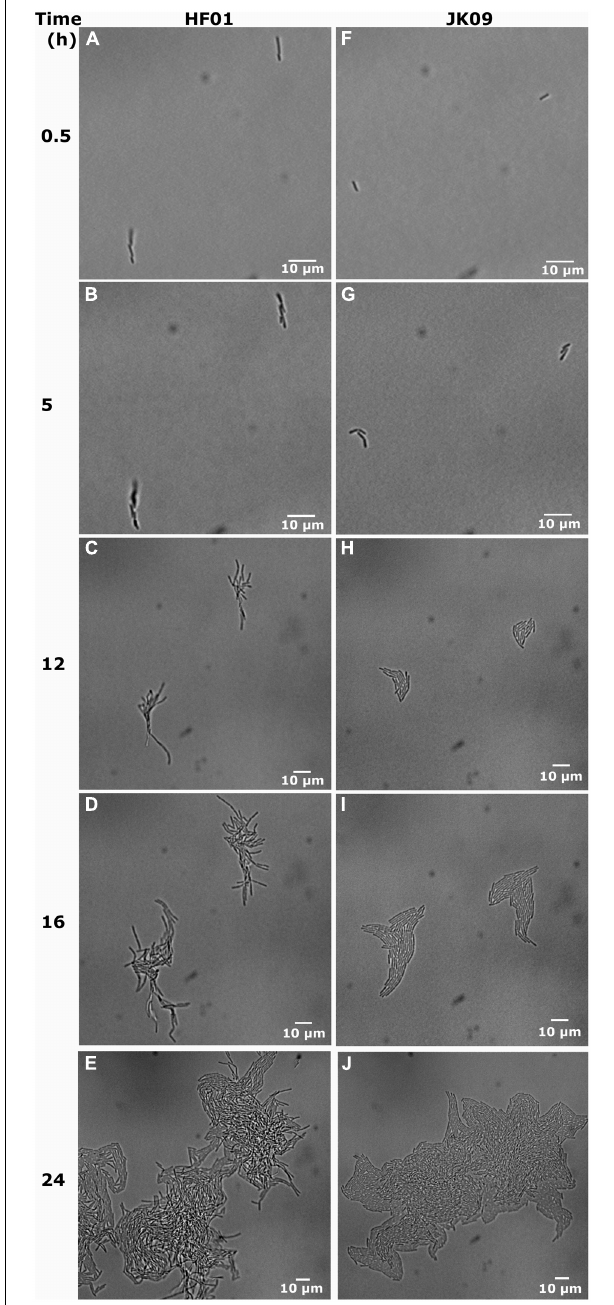
FIGURE 3 | Development of individual cells for HF01 control and JK09 control on MRS agar after anaerobic cultivation. (A) , (B) , (F) , (G) have the same magnification; (C) , (D) , (H) , (I) have the same magnification and (E) , (J) have the same magnification.